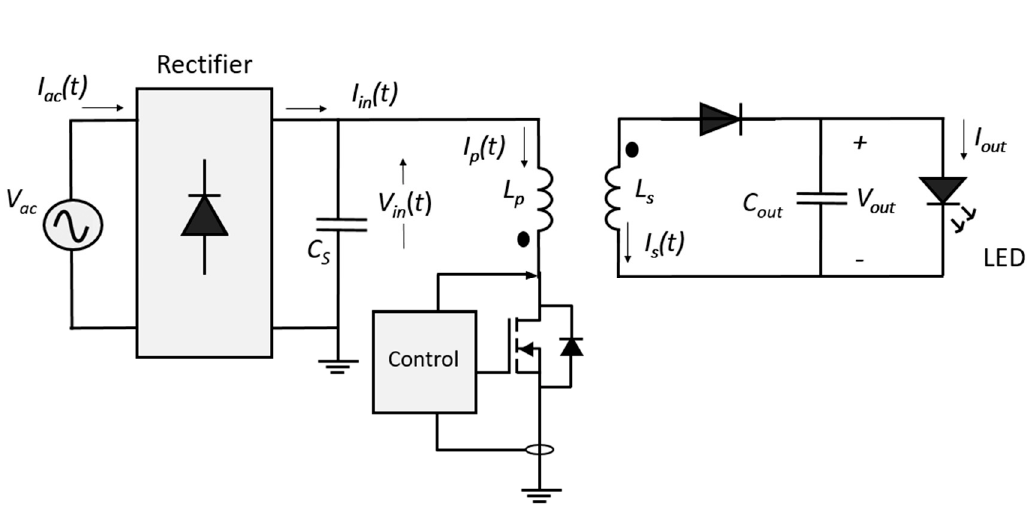
Figure 7. QR resonant flyback valley-switching.